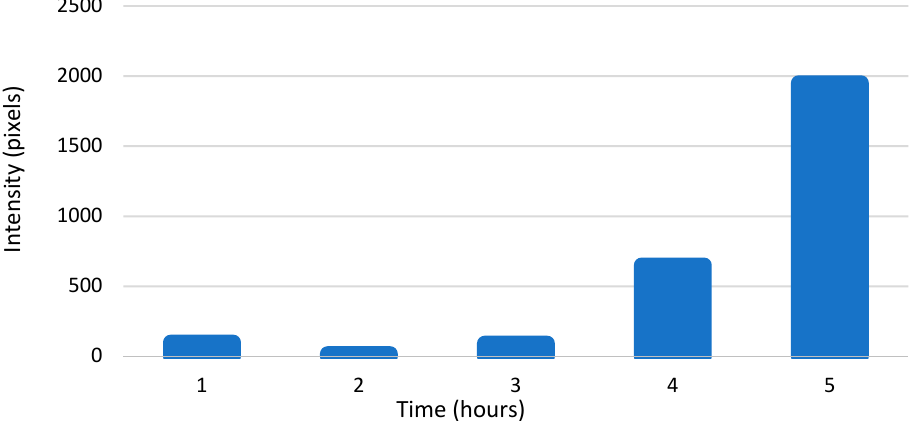
Figure 5. The amount of viral +RNA in CVA9-infected cells at timepoints 0–5 h p.i., as calculated from branched DNA (bDNA) fluorescent in situ hybridization (FISH) image intensity values. The bars represent pixels that have intensity values above the background threshold, calculated from ≈ 100 cells.